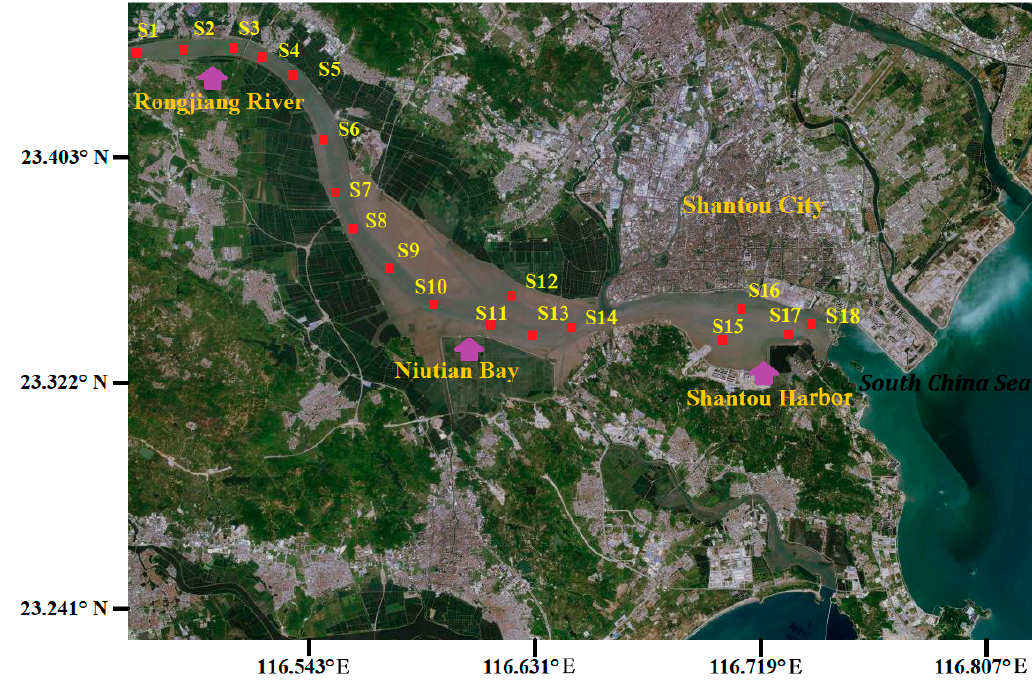
Figure 1. Distribution of sampling sites in Shantou Bay, South China.